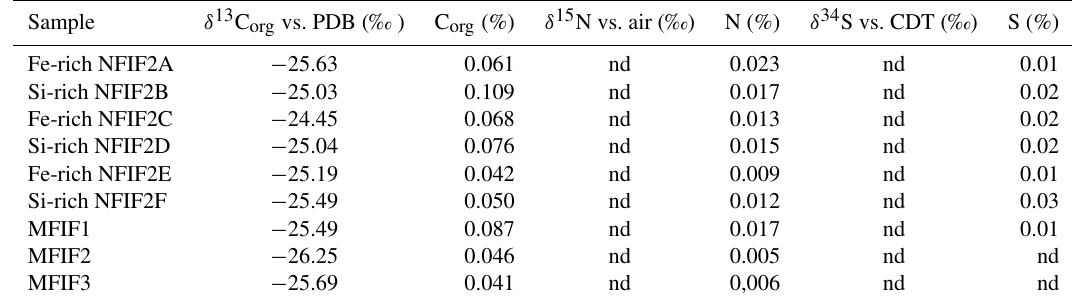
Table 2. Stable isotope results. Letters A–F on the NFIF samples represent respective bands of the sawn rock in Fig. 7e. PDB: Pee Dee Belemnitel CDT: Canyon Diablo Troilite.